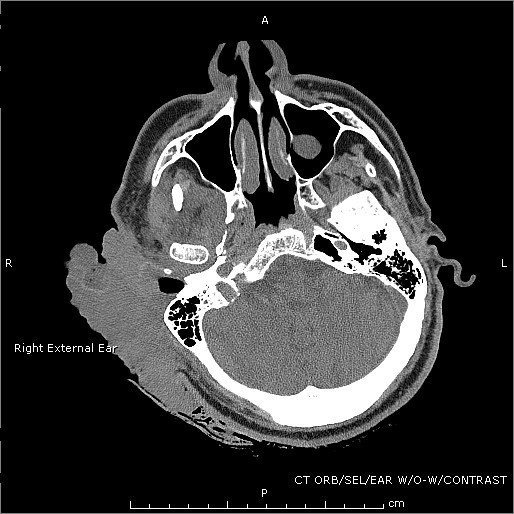
Ear cross section.